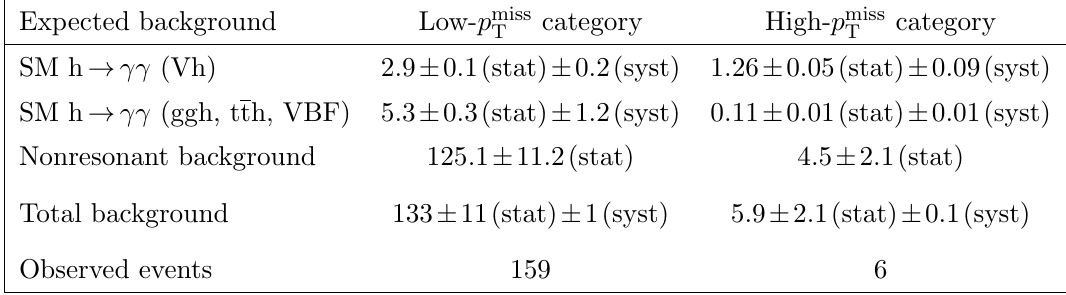
categories. The T